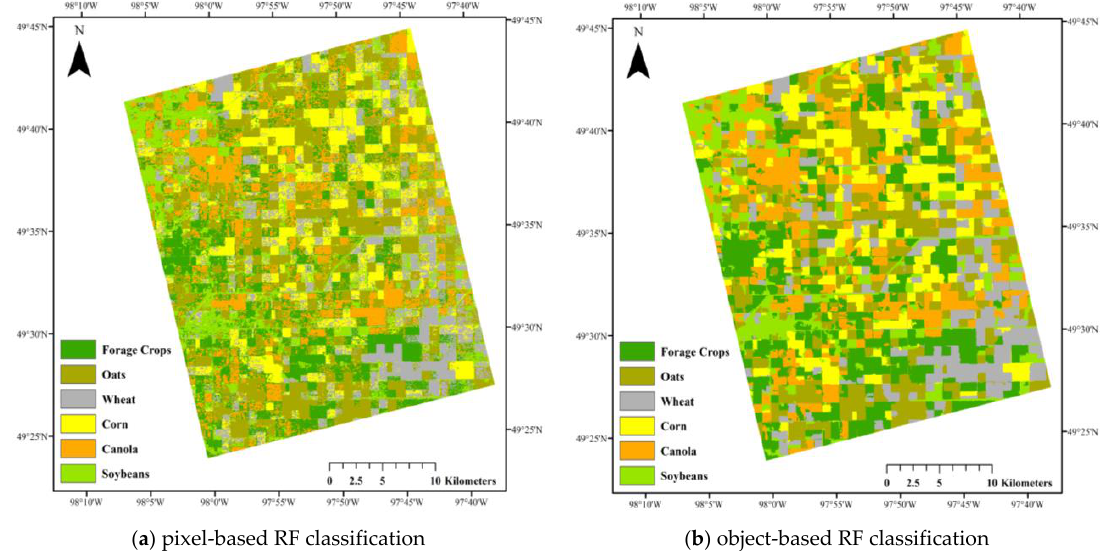
Figure 10. The final land cover maps obtained from the uncorrelated DP SAR features using ( a ) pixel-based and ( b ) object-based RF classifications.